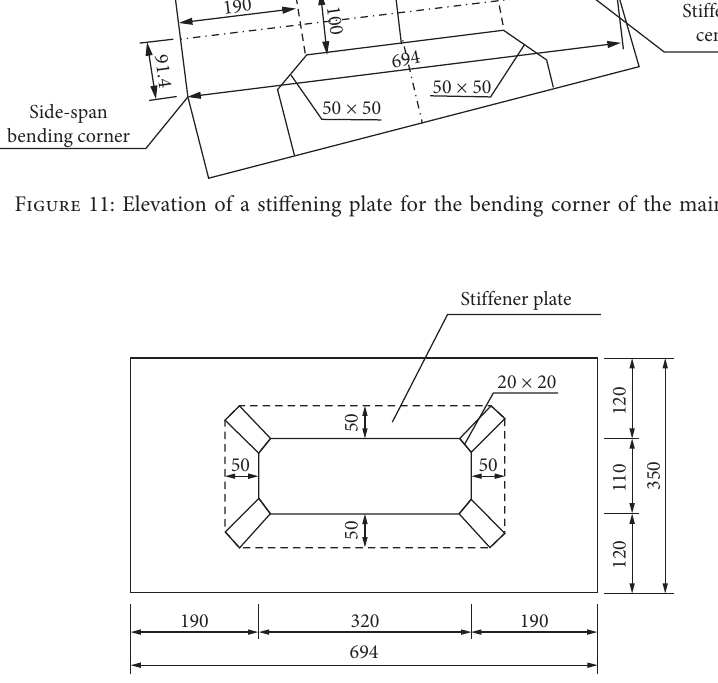
Figure 12: Plan incorporating a stiffening plate of the bending corner of the main